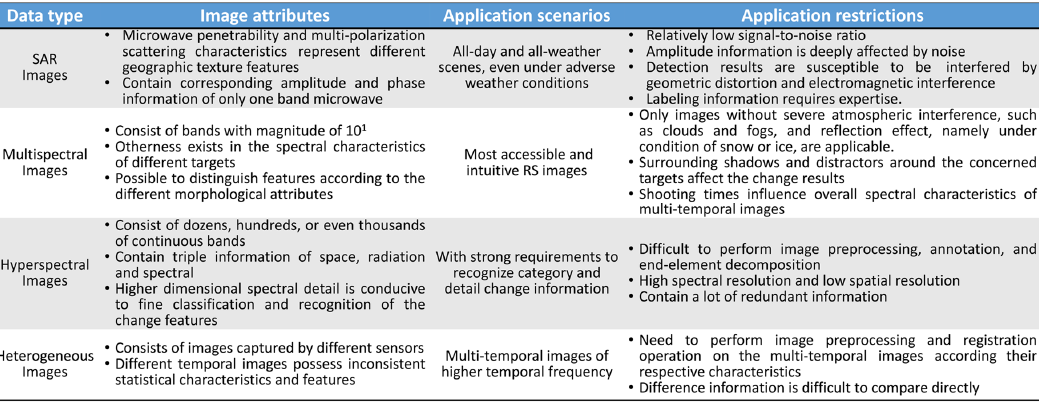
Figure 9. Summary of multi-source datasets.